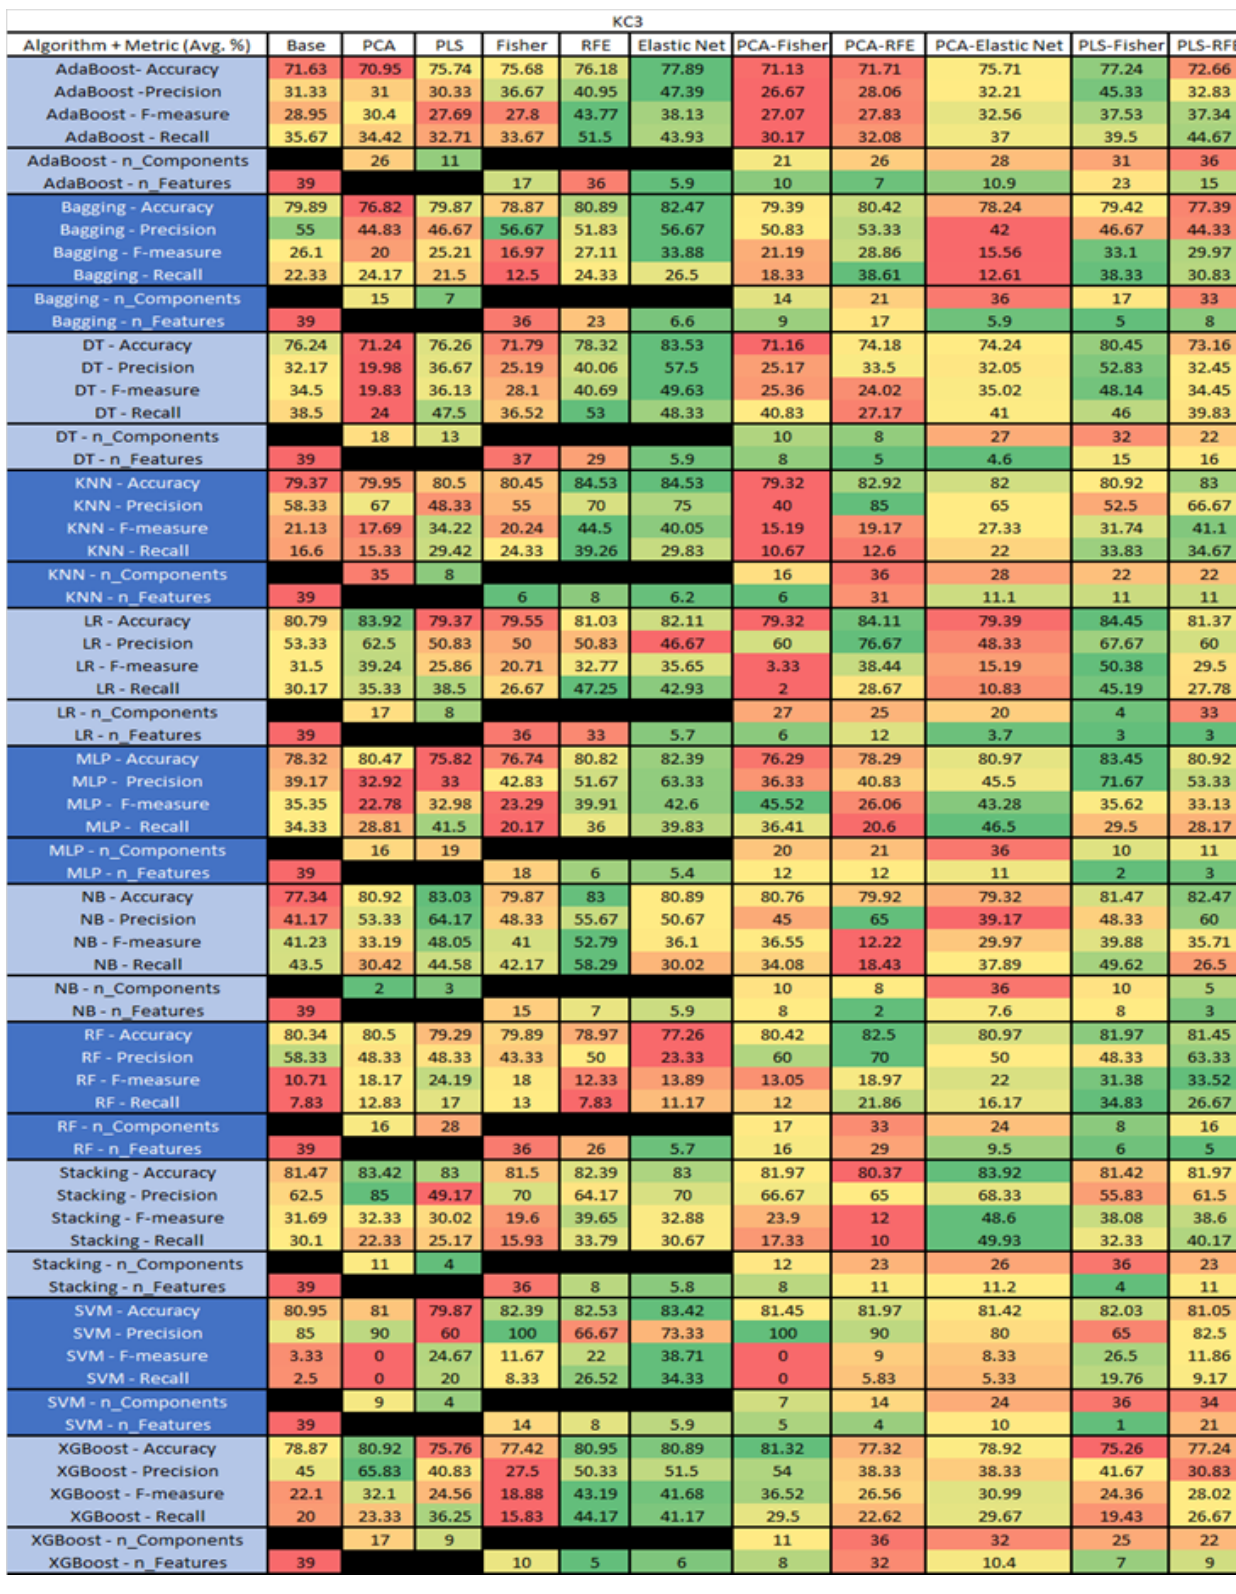
Figure 28. KC3 NASA MDP Results Data